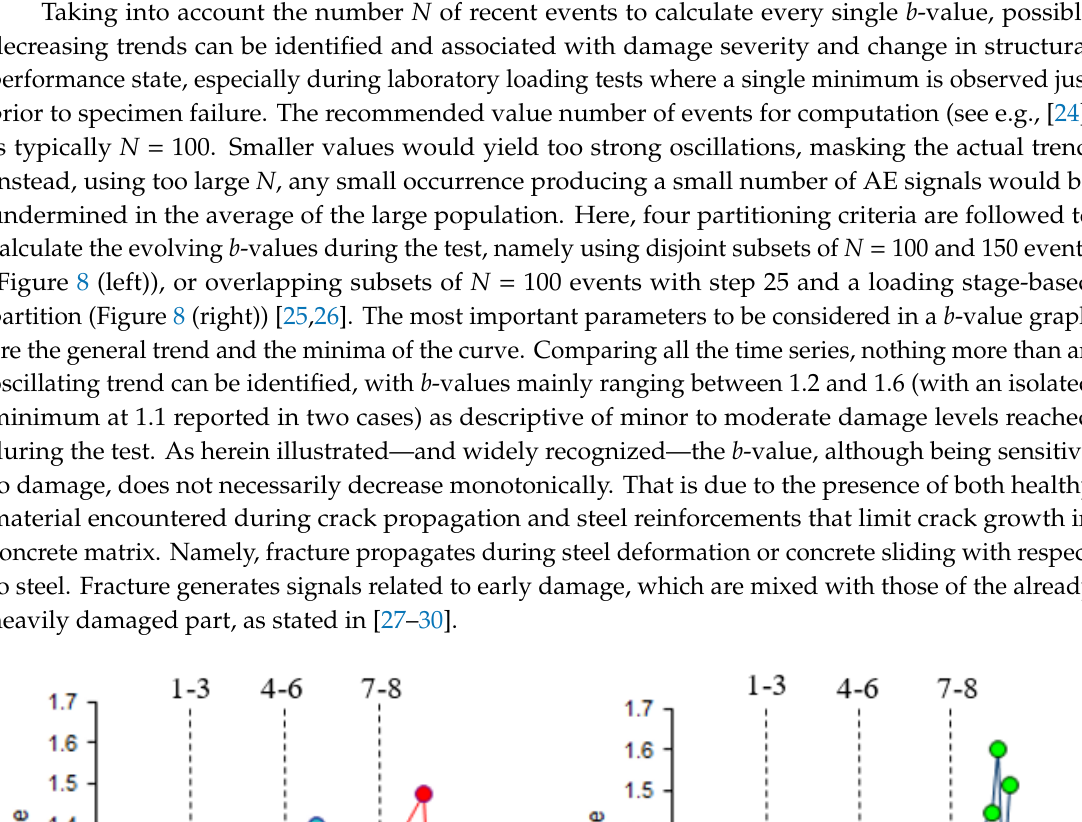
Figure 7. AE magnitude distribution for different damage conditions: low damage (high b -value) and high damage (low b -value).